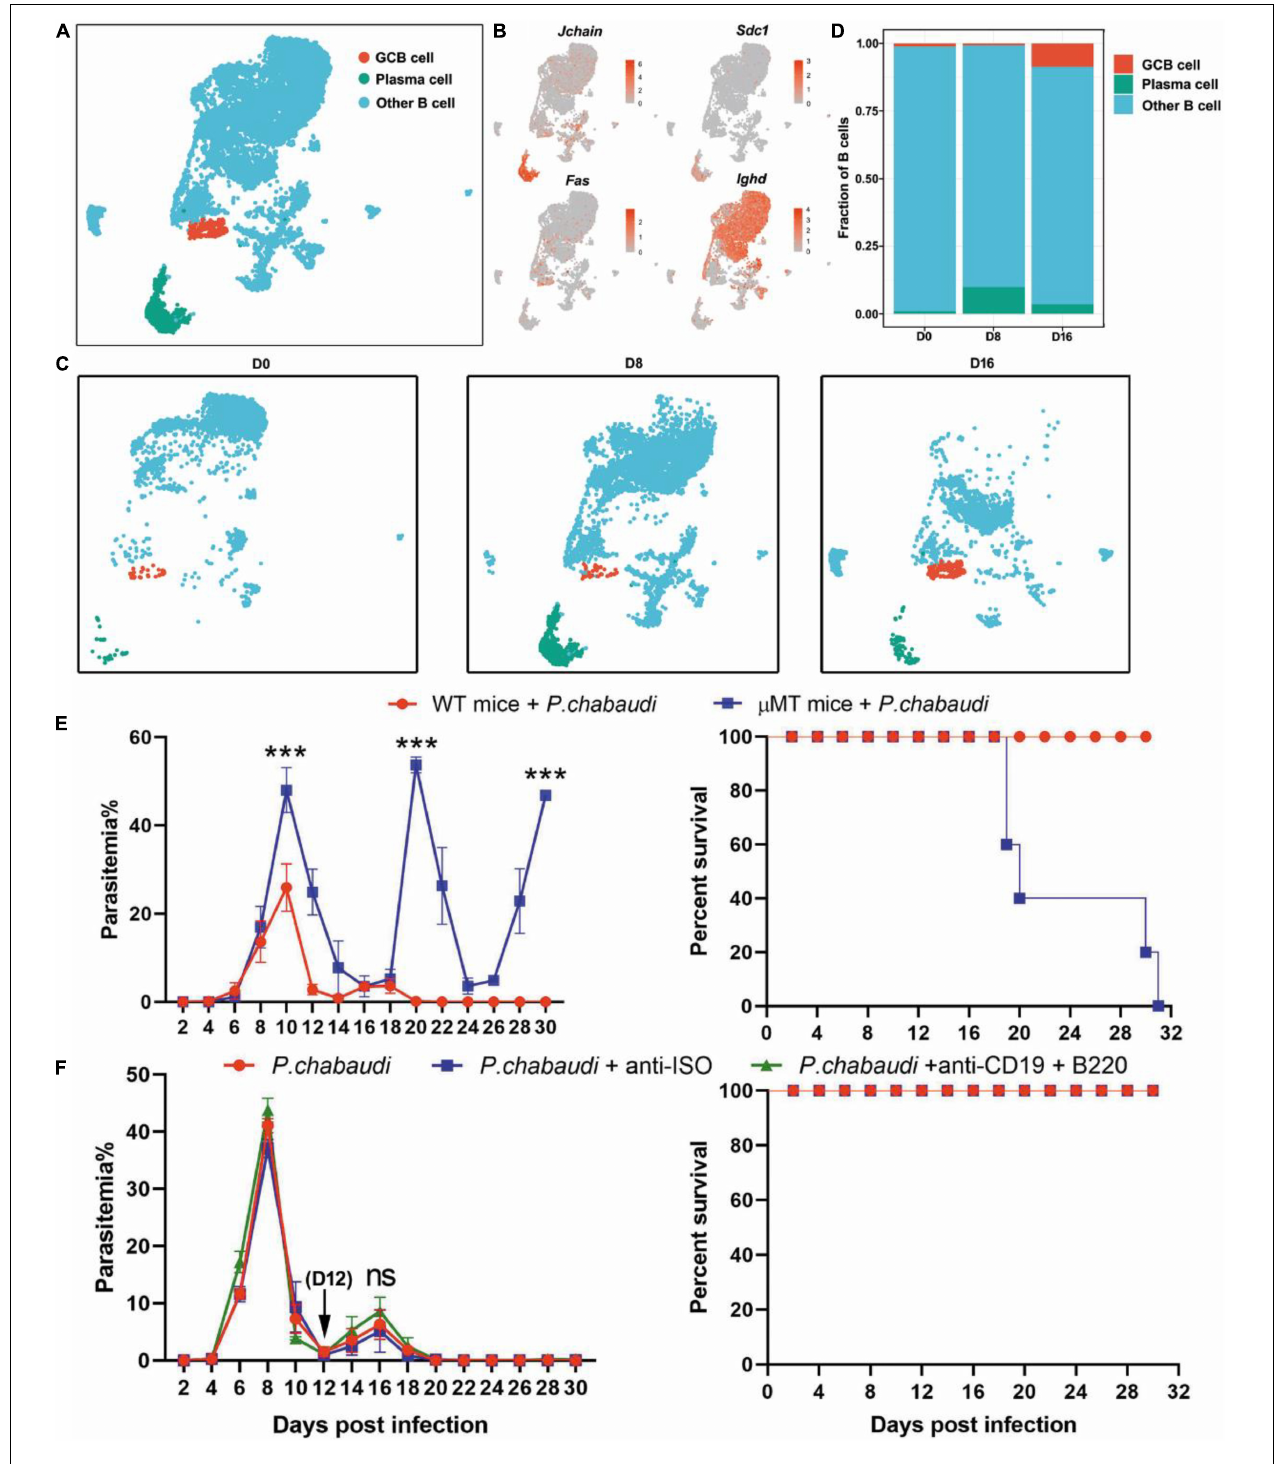
FIGURE 3 | Divergent role of B cells in the control of acute and recurrent P. chabaudi infection. (A) UMAP projection and graph-based clustering of B cells pooled from all samples. (B) Expression of markers driving heterogeneity between B cell subtypes, including the GC B cells and plasma cells. (C) Visualization of UMAP plot from (A) split by samples during the three stages of infection. (D) Proportion of B cell populations relative to total number of B cells at each time point. (E) B cell-deficient mice and littermates ( µ MT, n = 5) were challenged intraperitoneal (i.p.) with 1 × 10 6 pRBCs and the parasitemia and survival rate were recorded. (F) WT mice ( n = 5) were injected with anti-B220 and anti-CD19 or control IgG on days 12, 14, 16, 18, 20 after the challenge. All experiments were performed in triplicates and the data are presented as means ± SD. ns, not significant; *** P <